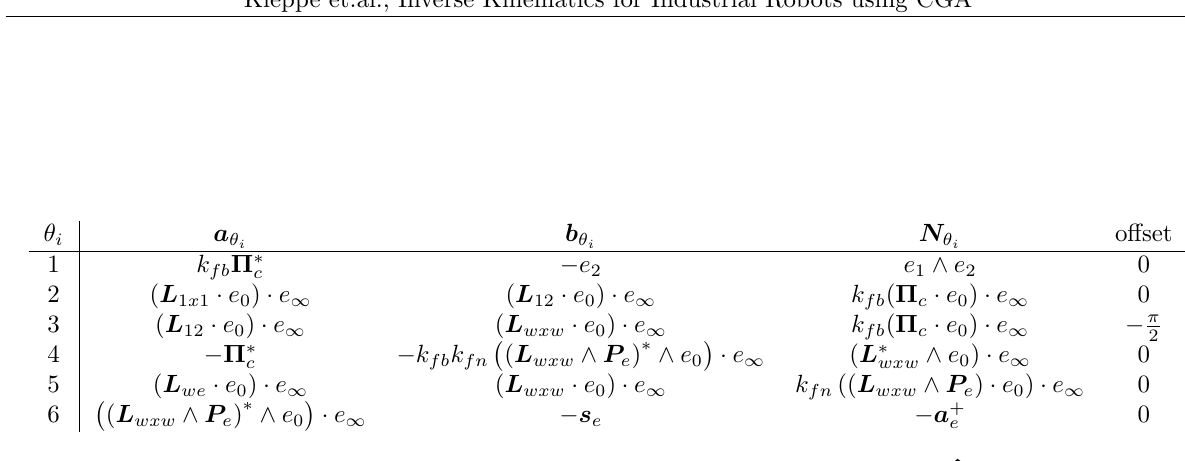
is the rotational axis i